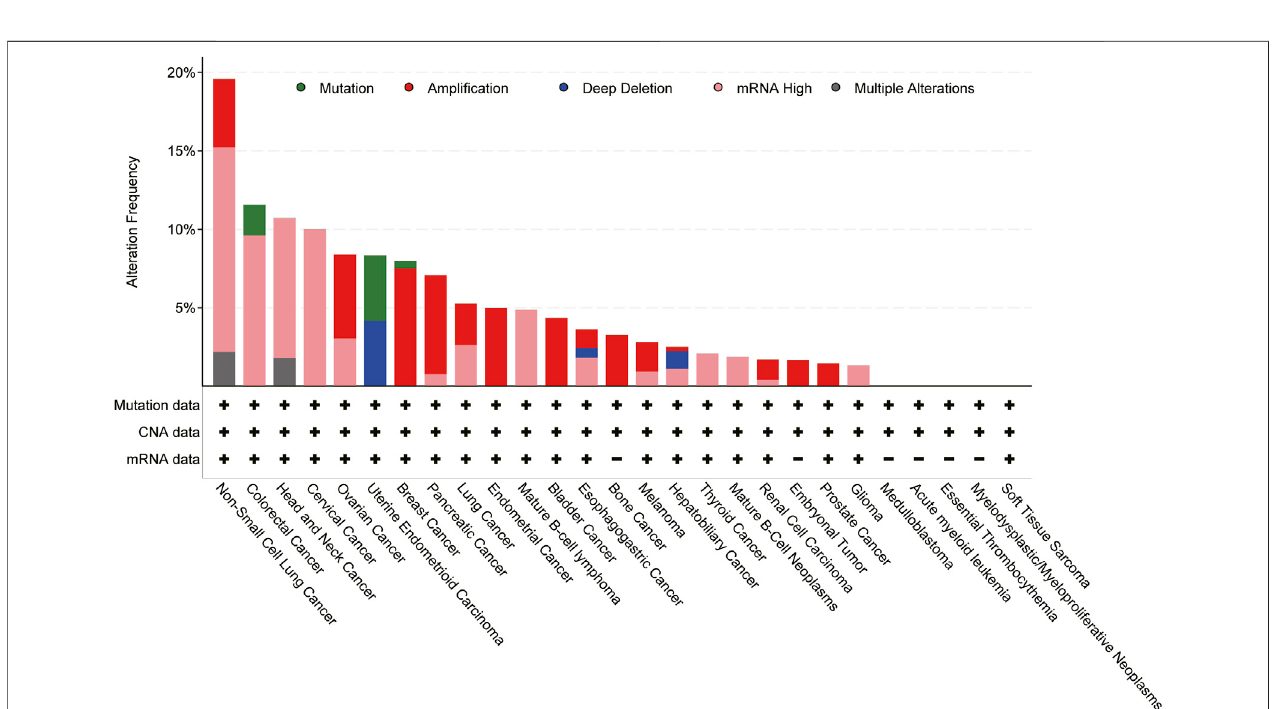
FIGURE 3 | Genomic alterations of CXCL8 cross 27 cancer types; TCGA pan-cancer cohort from cBioPortal for Cancer Genomics were used for this analysis.